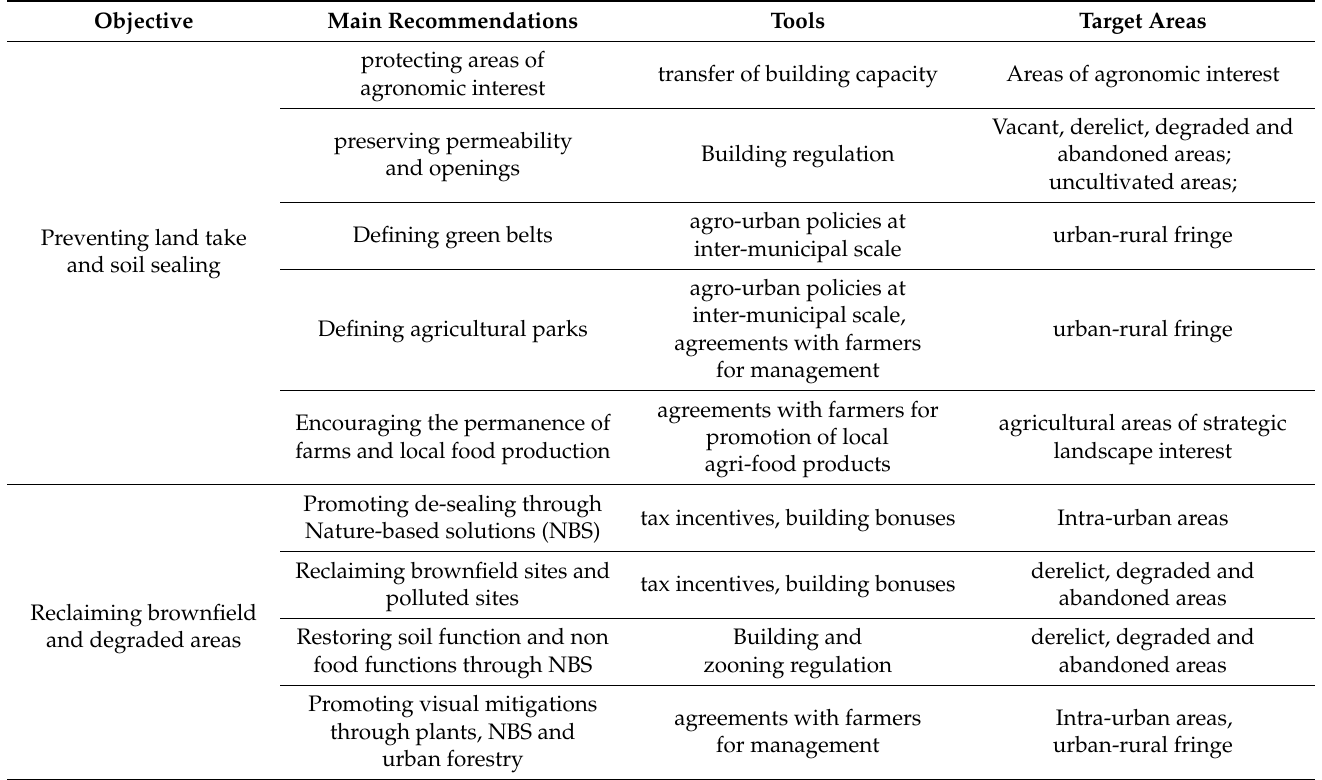
Table 3. Guidelines for open spaces in the Turin peri-urban